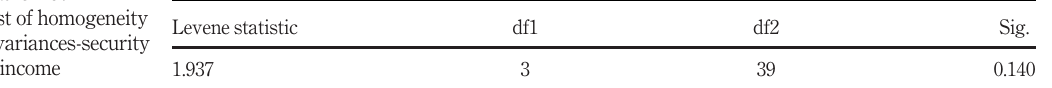
Table 10. Test of homogeneity of variances-security by income